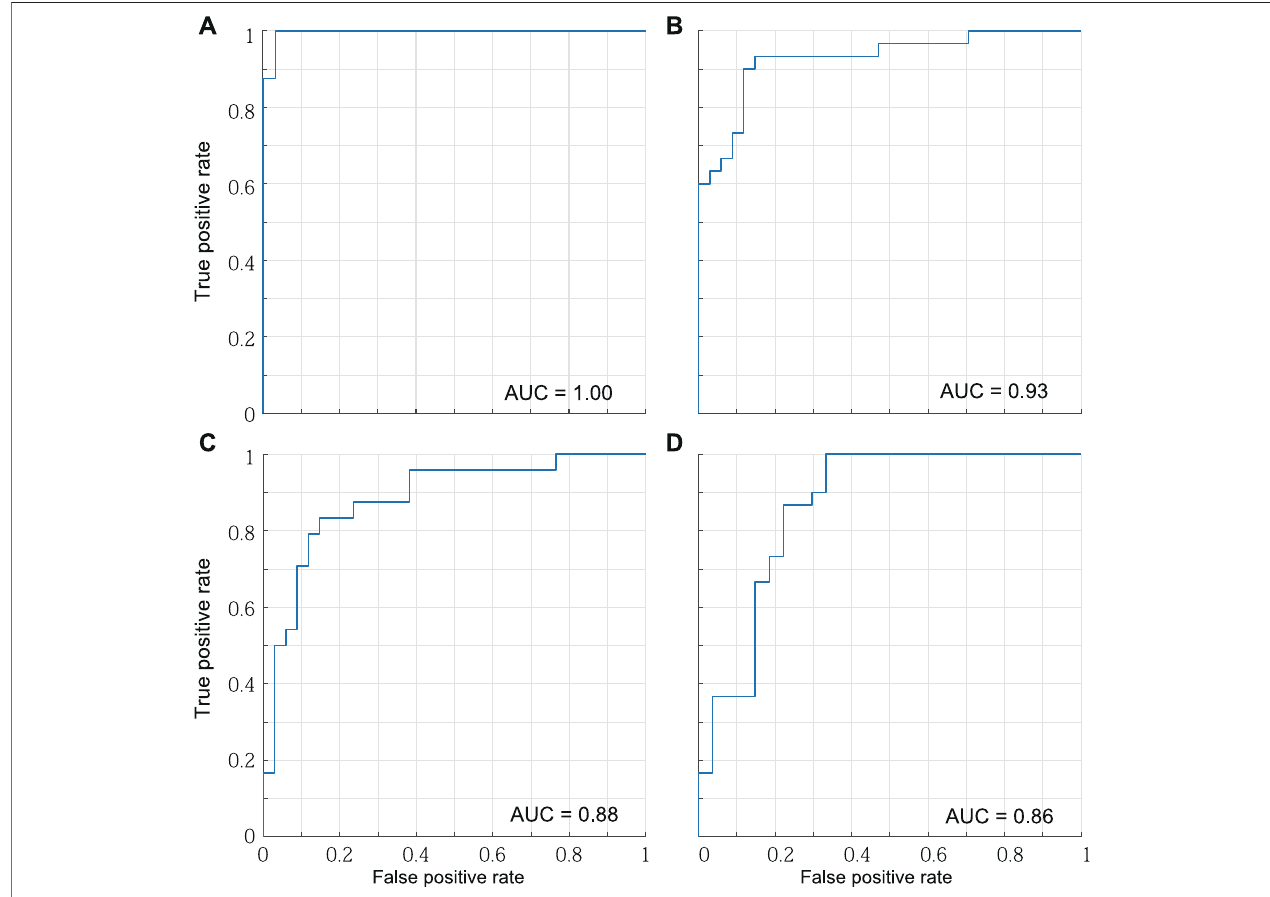
FIGURE 7 | ROC curves and AUCs. (A) Mild PD patients and healthy older individuals. (B) Mild PD patients and healthy young individuals. (C) Healthy older individuals and young individuals. (D) Mild and advanced PD patients.